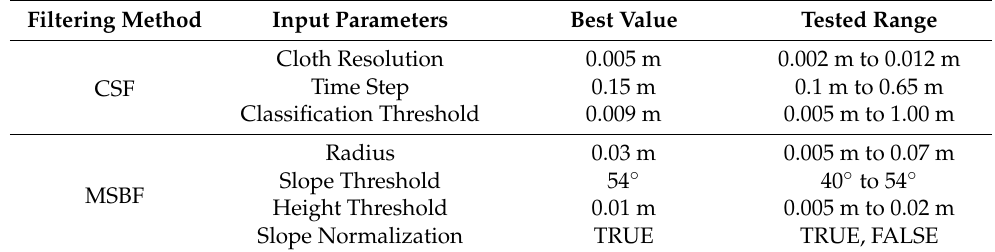
Table 1. Input parameters of the highest performance by Kappa scores for CSF and MSBF based on the subset of the testing dataset.